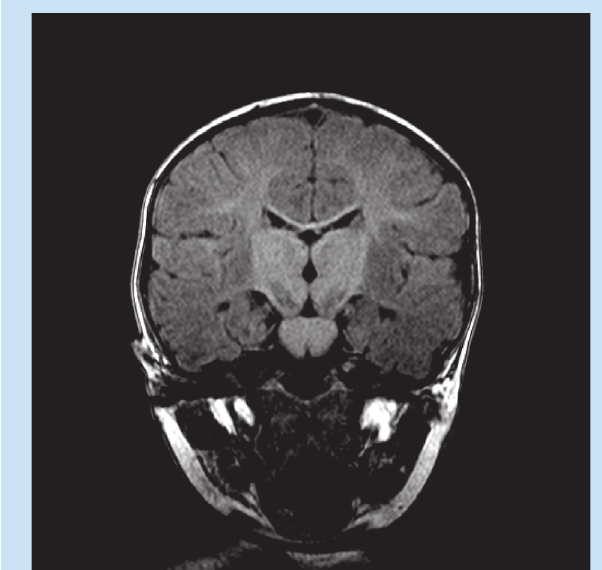
Fig. 3. Coronal MPRAGE demonstrating diffuse thalamic hyperintensity.